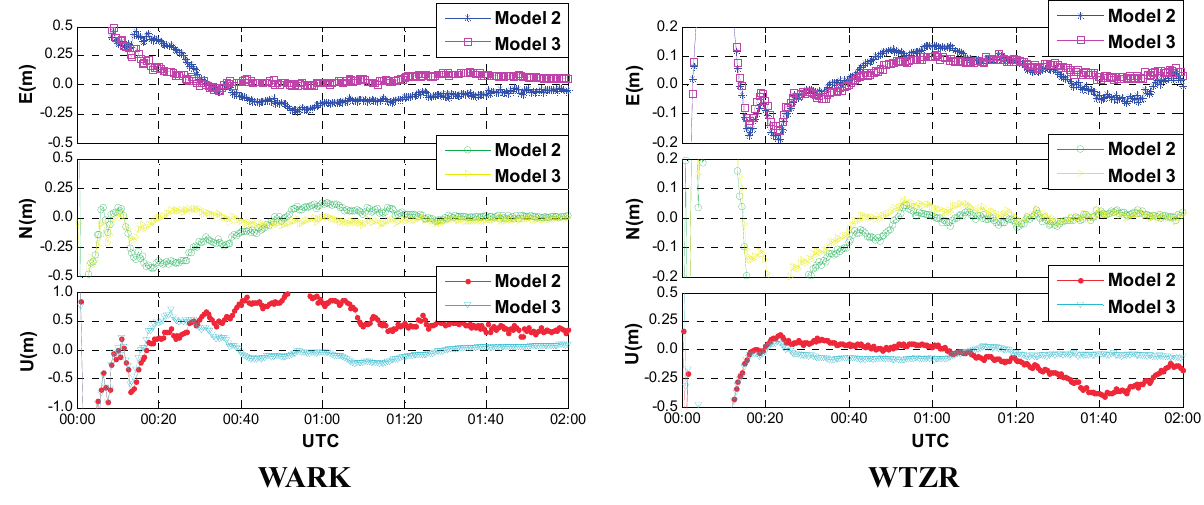
Figure 5. Convergence performances of the kinematic GPS/GLONASS PPP (Model 2 vs. Model 3).